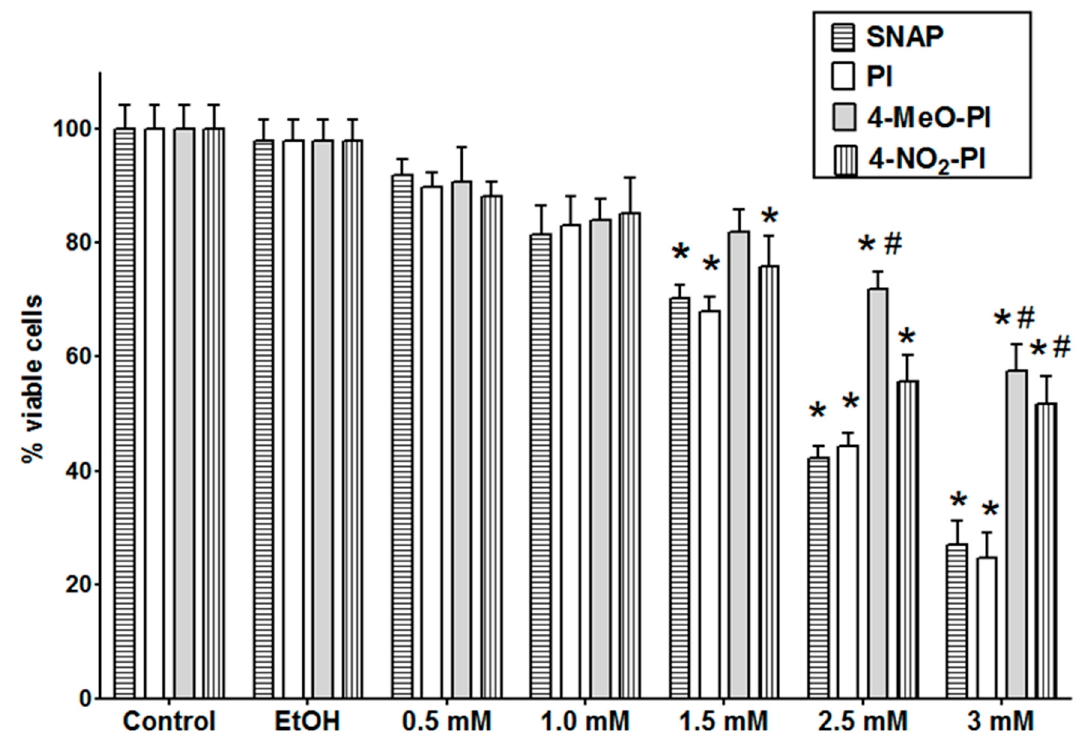
Figure 7. Effects of SNAP, PI, 4-MeO-PI and 4-NO 2 -PI on PC12 cell viability. PC12 cells were incubated in drug-free medium. At the start of each experiment, 100 × 10 3 cells/cm 2 were plated and treated 24 h later (time 0) with different concentrations of SNAP, PI, 4-MeO-PI and 4-NO 2 -PI (0.1, 0.5, 1, 1.5, 2 mM). After 24 h, the number of viable cells was determined in triplicate wells. Cell viability was established by the MTT assay. Results are given as percent of control PC12 cells and represent the mean ± SEM of three experiments. * p < 0.05 compared with controls; # p < 0.05 compared with corresponding ethanol concentrations.